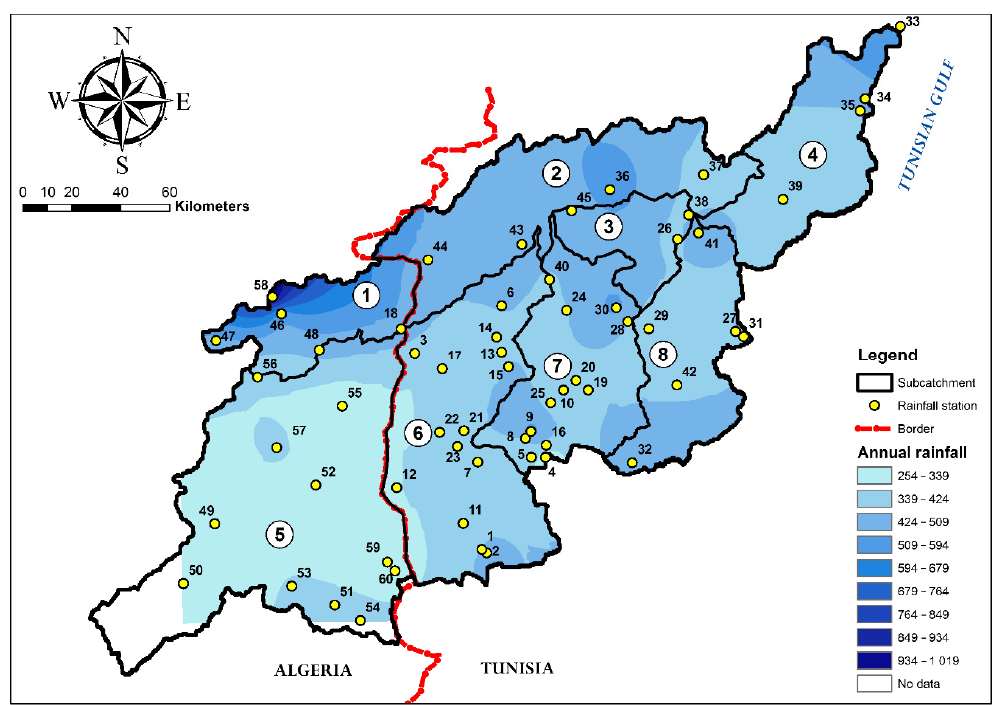
Figure 3. Variation of average annual rainfall (1970–2007) over the Medjerda catchment. Numbers in the circles represent the subcatchment ID (same as Figure 1).